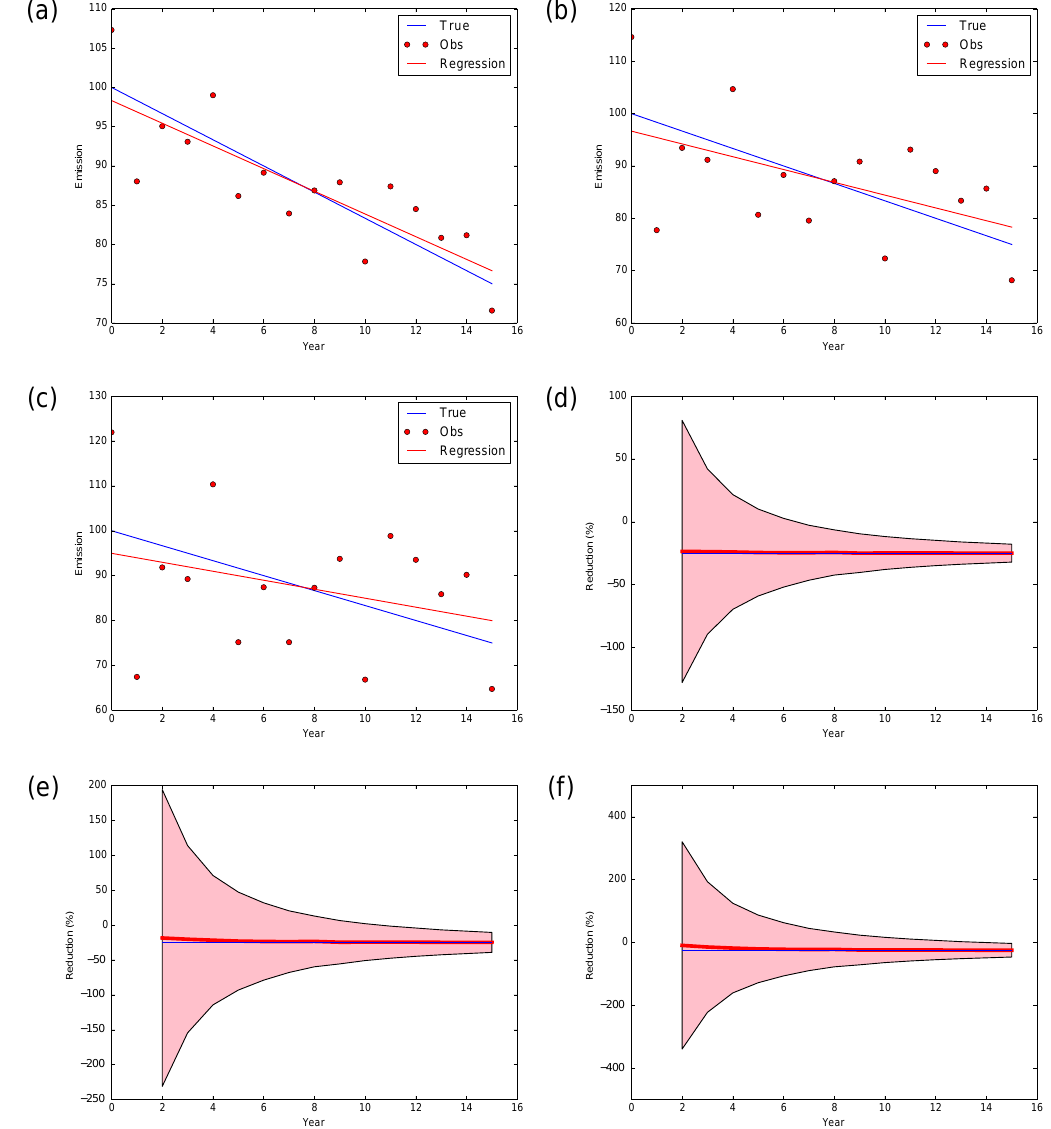
Figure C1. Detection of linear trends using the Monte Carlo method with ensembles of 10000 simulations. We hypothesize that the emissions decrease linearly from a value of 100 in any appropriate unit to 75 (i.e., a 25% reduction) in a 15-years time horizon. (a) , (b) , and (c) show the linear trends detected by linear regressions (red lines) using series of emissions, which are obtained by perturbing the hypothesized emission values (blue lines) under 5, 10, and 15% 2 σ annual emission uncertainties, respectively (in percentage to the emission value in the initial year). (d) , (e) , and (f) show the increasing 2 σ accuracy of the trend detections with increasingly available emission data along years. The detection accuracy is calculated from statistics of regression results for 10000 simulations.